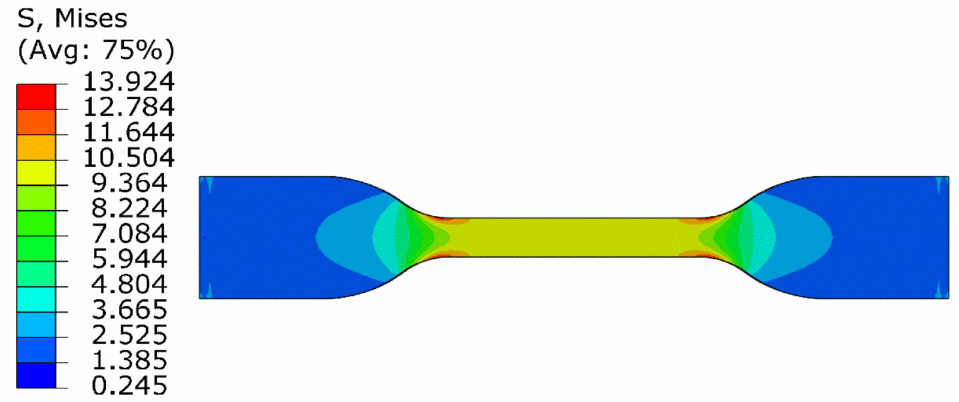
Figure 16. The stress contour profile of rubber specimen NR-1at 283 K by finite element analysis (FEA).